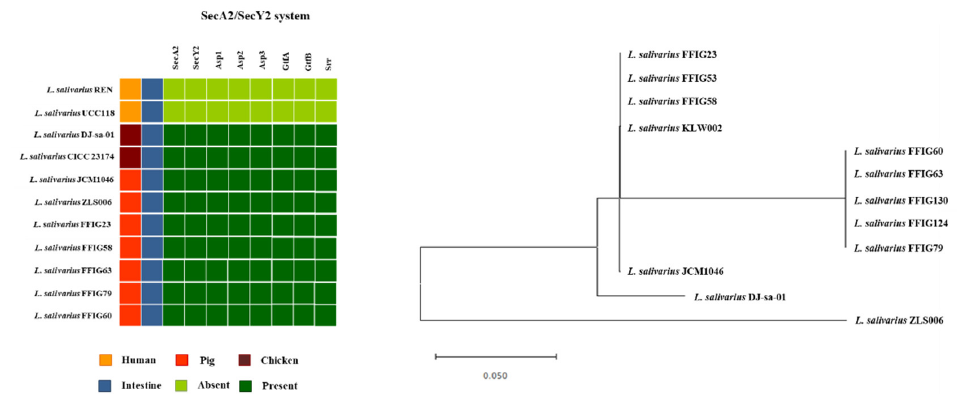
Figure 9. Genomic comparison of the SeA2-SecY2 accessory secretion system from Ligilactobacillus salivarius strains isolated from the intestinal mucosa of wakame-fed pigs and probiotic L. salivarius strains isolated from the intestinal tract of humans, pigs, and chickens. The phylogenetic tree was constructed by using the sequences of the genes secA2 , secY2 , asp1 , asp2 , asp3 , gtfA , and gtfB sheared by the strains of animal origin.